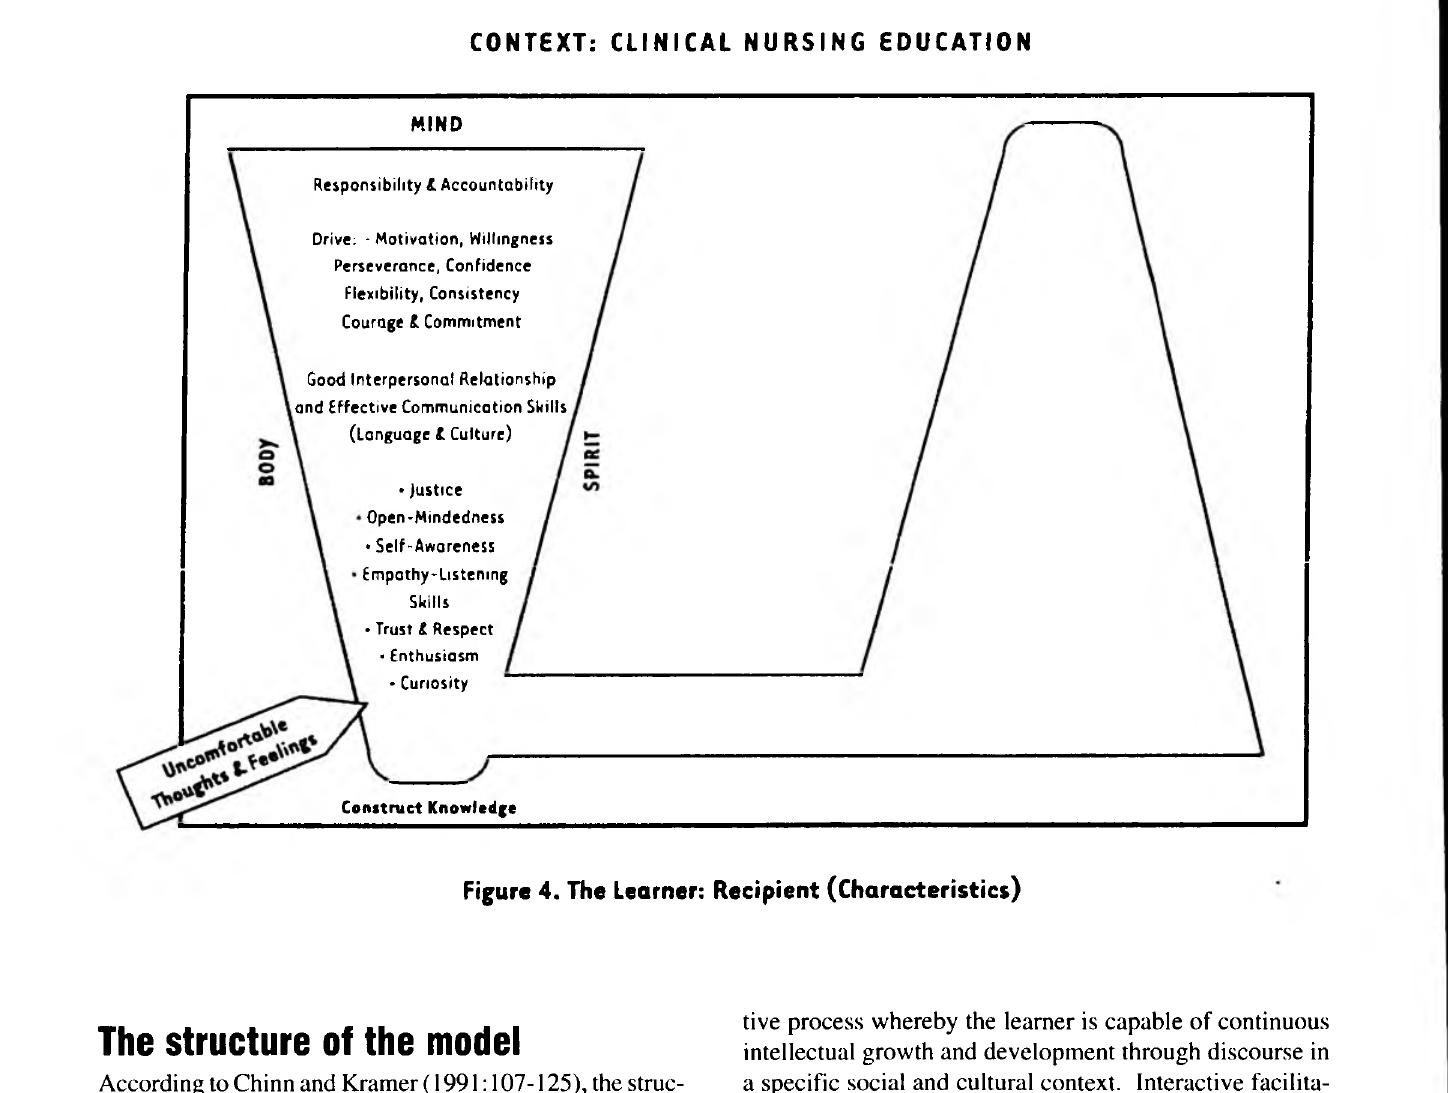
Figure 4. The Learner: Recipient